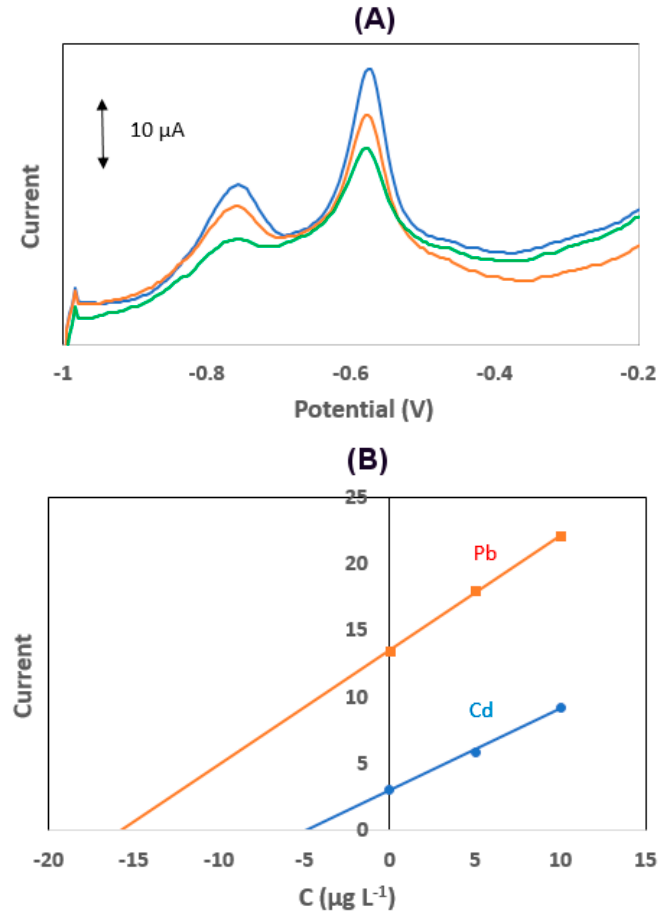
Figure 7. ( A ) Voltammograms for the determination of Pb(II) and Cd(II) in a phosphorite sample; ( B ) standard additions plots. Conditions as in Figure 4; the sample was spiked with 2.0 × 10 − 5 mol L − 1 K 4 [Fe(CN) 6 ] before the analysis.